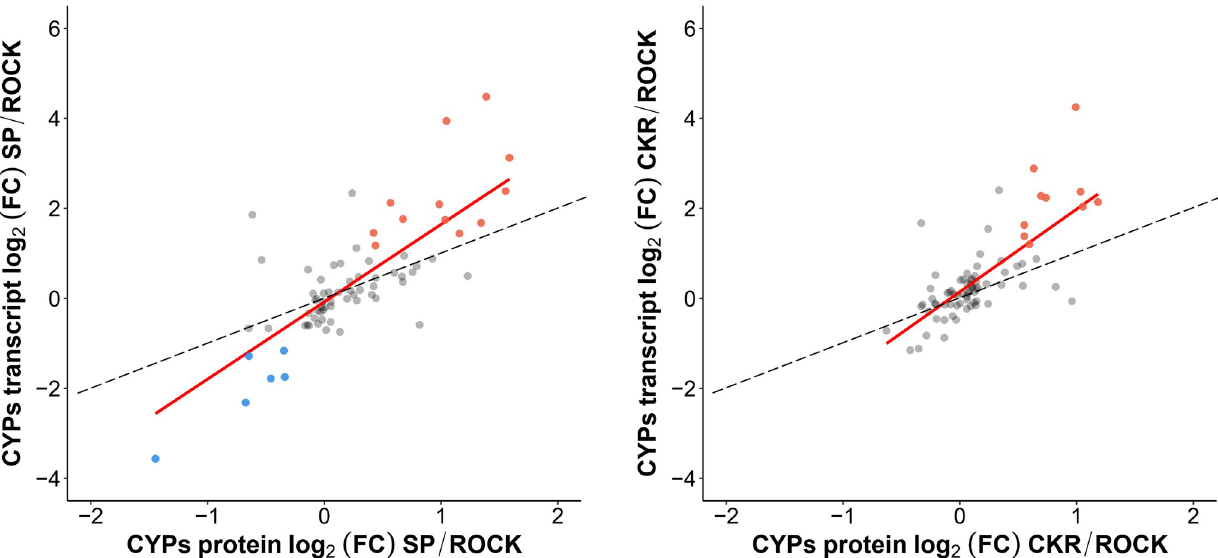
Fig 6. Correlation plots of the log 2 (FC) between detected CYP proteins and transcripts (red line) for SP and CKR relative to ROCK. A: Correlation plot of the log 2 (FC) between detected CYP proteins and transcripts for SP relative to ROCK. B: Correlation plot of the log 2 (FC) between detected CYP proteins and transcripts for CKR relative to ROCK. The dashed line represents a slope of 1.0.